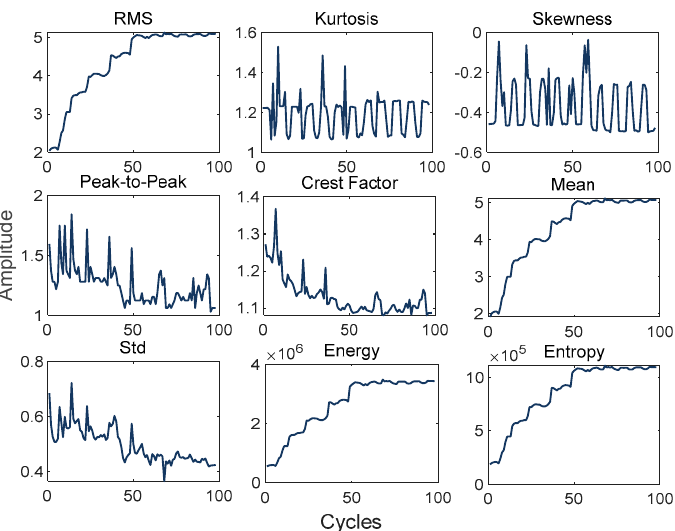
Figure 8. The evolution of the extracted features using a time-domain analysis of the Vce measurement.